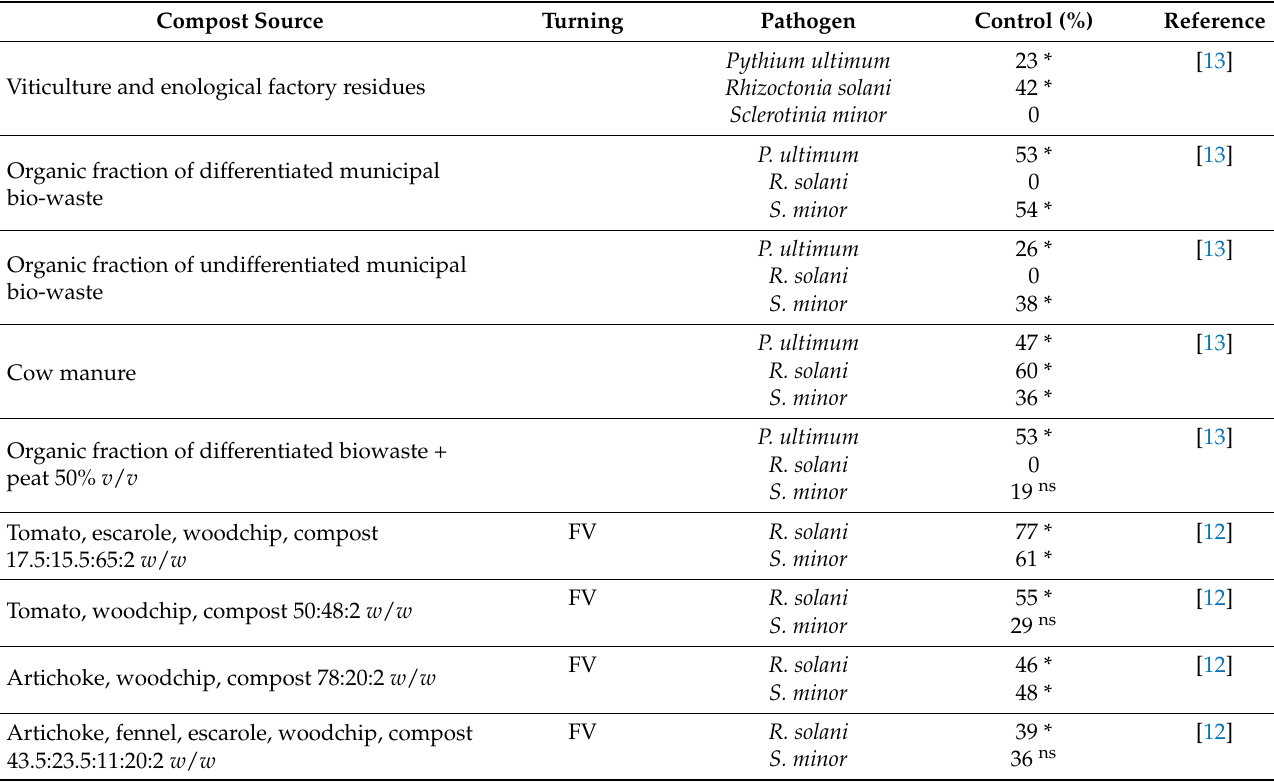
Table 1. Percentage of control efficacy showed by many composts tested against soil-borne diseases of cress in previous studies. The asterisk indicates statistical significance ( p < 0.05); ns indicates not significant, as compared to the infected